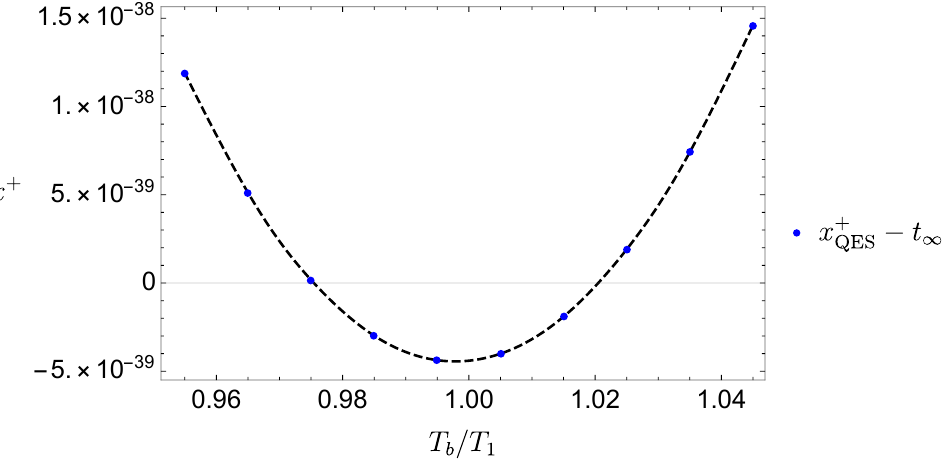
Figure 8 . The numerical results from solving QES equations for the deviation of QES from (cid:0) (cid:1) horizon, i.e. x + − t ∞ , at a fixed time slice u = 40 (after Page transition) with different bath QES temperatures T b